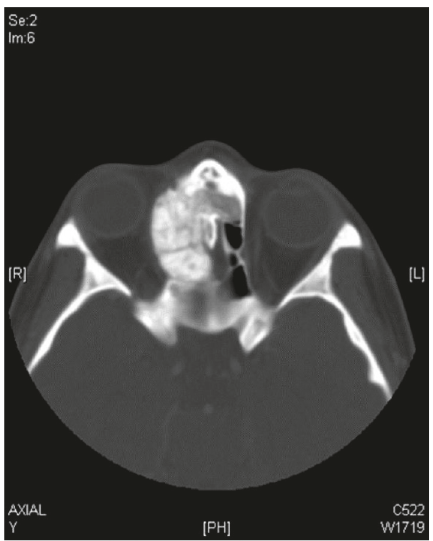
Figure 9: The paranasal axial CT scan demonstrates the right ethmoid sinus besides nasal hollow bulk by orbital then intracranial engrossment.